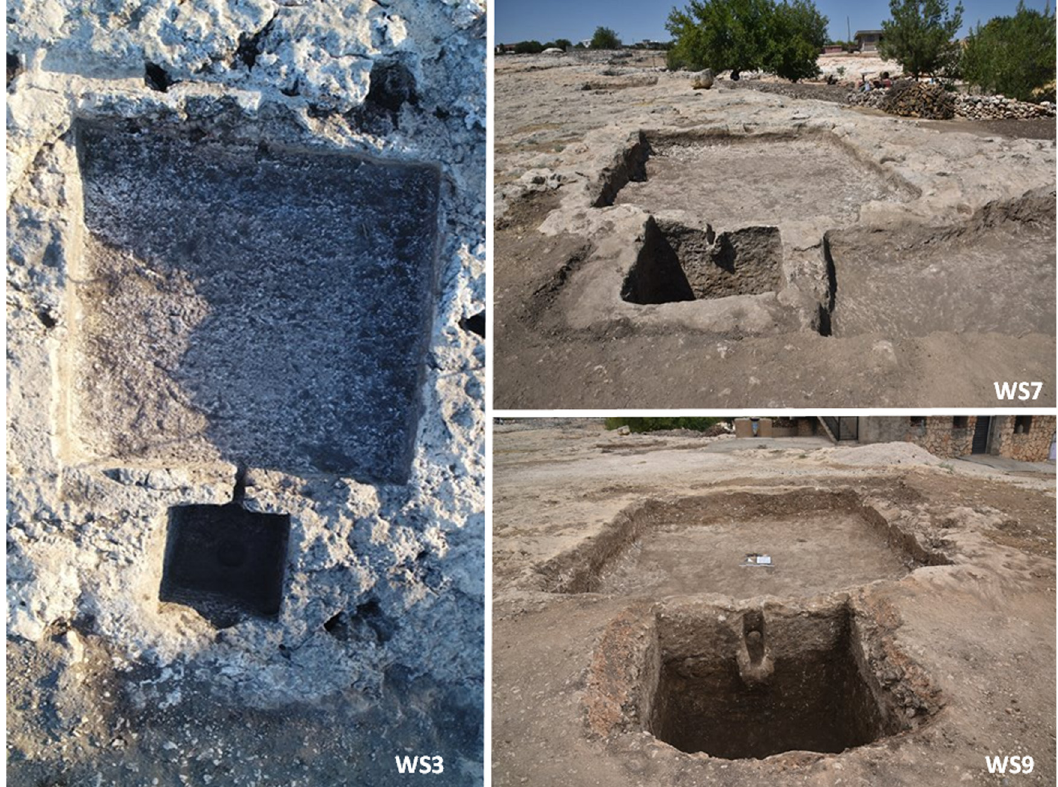
Figure 4: Samples showing orientation in North - South Direction ( Ambarçay Salvage Excavation Archive